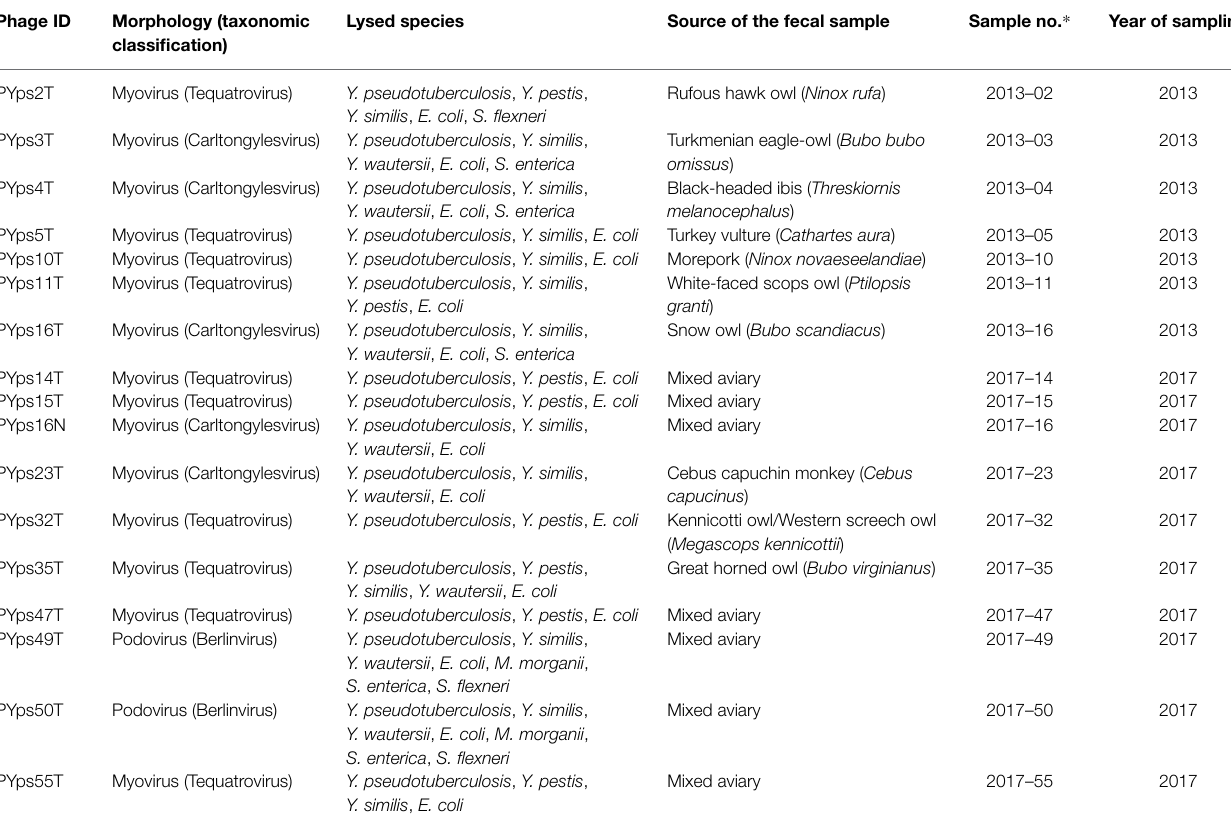
TABLE 3 | Origin of the phages analyzed in this